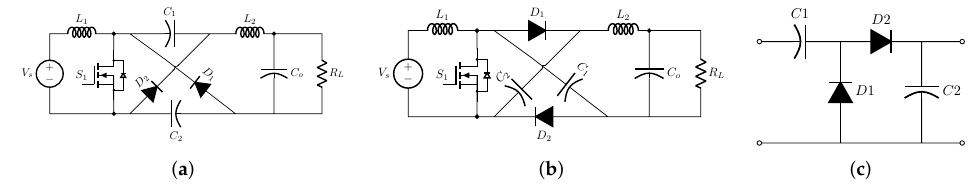
Figure 10. ( a ) and ( b ) Voltage Multiplier Cell (VMC), ( c ) Voltage Multiplier Rectifier